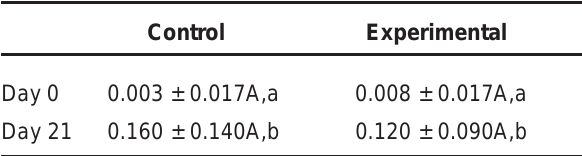
*means followed by the same uppercase letters on day 0 and day 21 do not differ statistically (p>0.05) **means followed by different lowercase letters in a same column differ statistically (p<0.05)